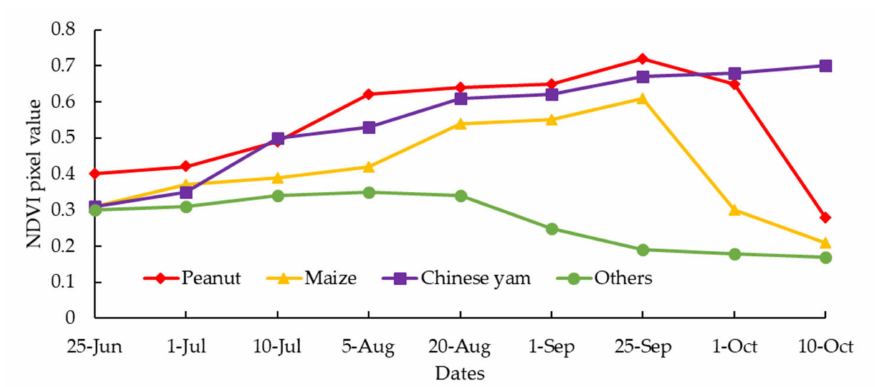
Figure 7. NDVI pixel values as a function of time.